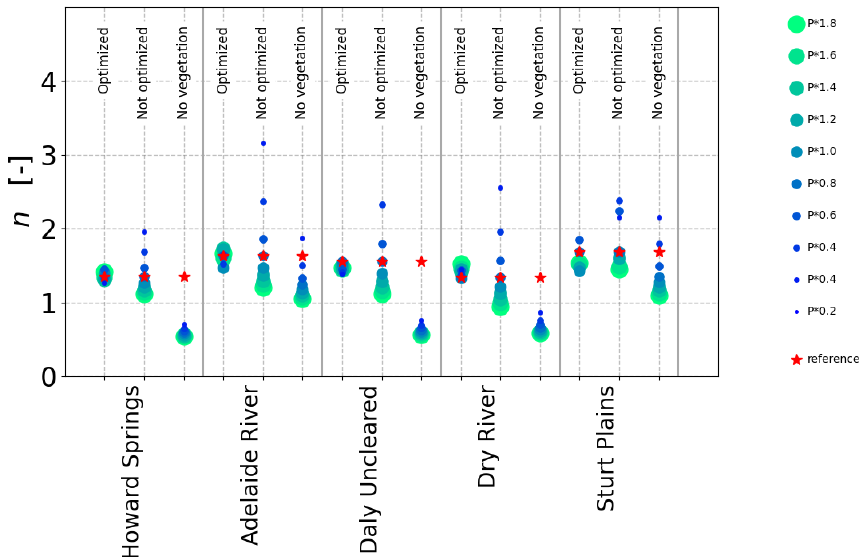
Figure 8. Variability of n in response to changing precipitation in the VOM. A separate n value was fitted to each point in Fig. 4. Sizes of dots represent the multiplication factor by which precipitation was modified at each site, while the red stars indicate simulations with unmodified precipitation. “Optimized”: fully optimized vegetation, “not optimized”: optimal vegetation properties of unmodified precipitation, and “no vegetation”: bare soil